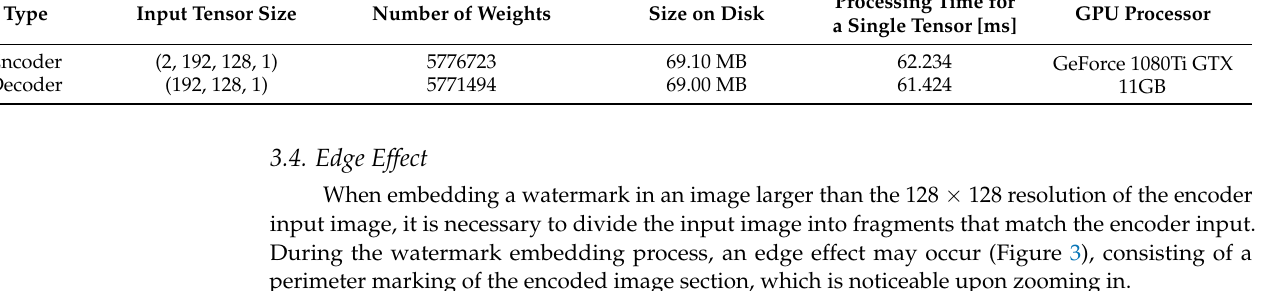
Table 6. Parameters of the encoder and decoder.